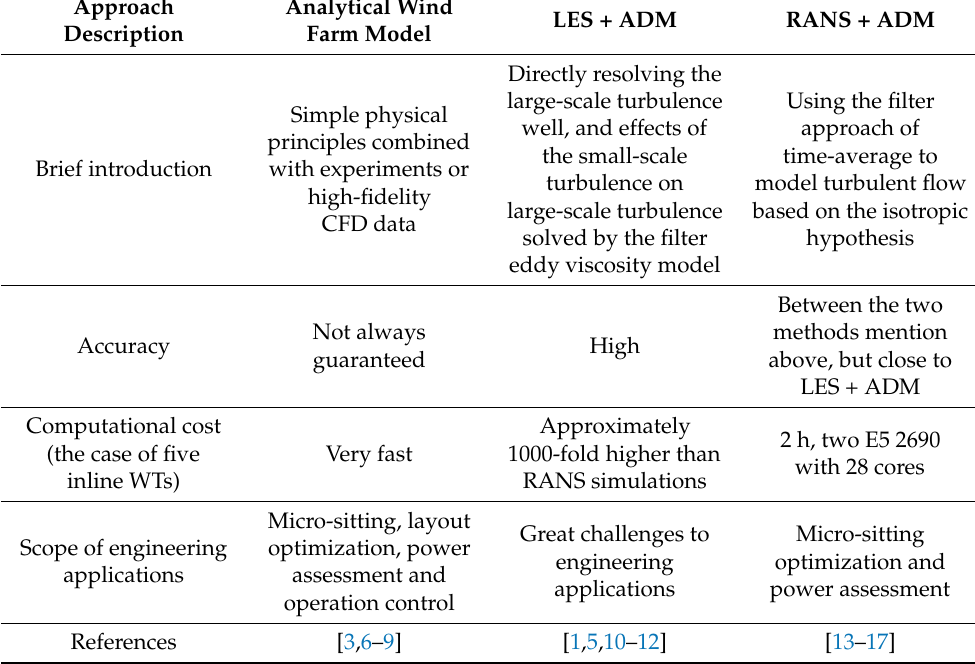
Table 1. Main methodologies of wind farm wake